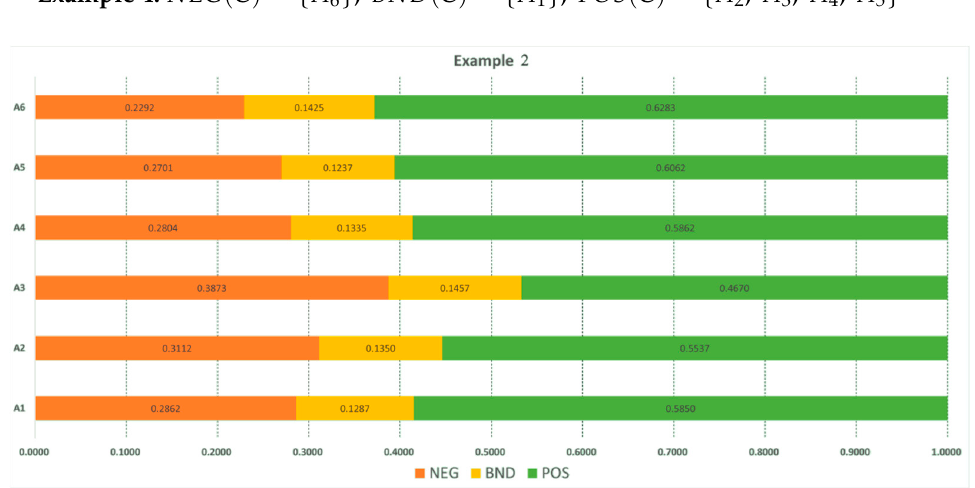
Figure 1. Results of the multi-attribute three-way decisions for Example 2.